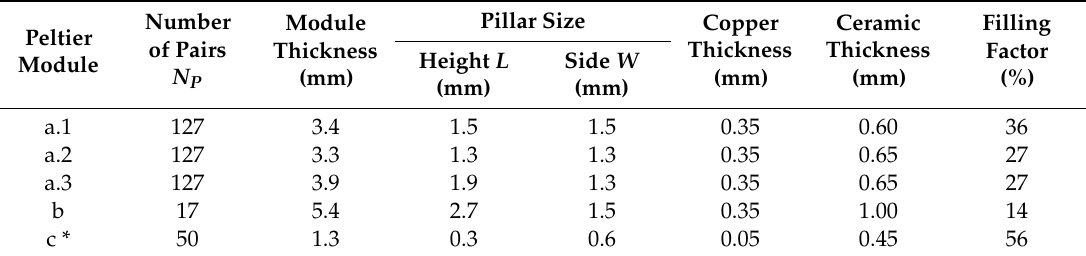
Table 1. Number of pairs and some geometric features of the investigated Peltier modules.